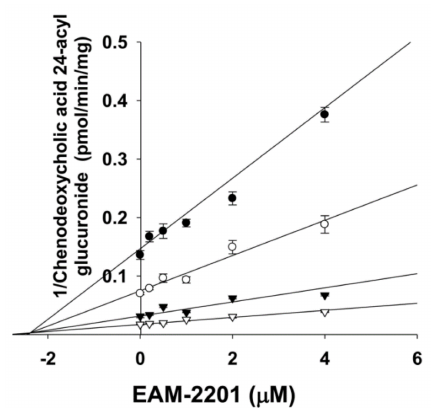
Figure 5. Representative Dixon plot showing the inhibitory effects of EAM-2201 on UGT1A3-catalyzed chenodeoxycholic acid 24-acylglucuronidation in human liver microsomes. Each symbol represents a particular concentration of chenodeoxycholic acid: , 1 µ M; are presented as the mean ± SD ( n =